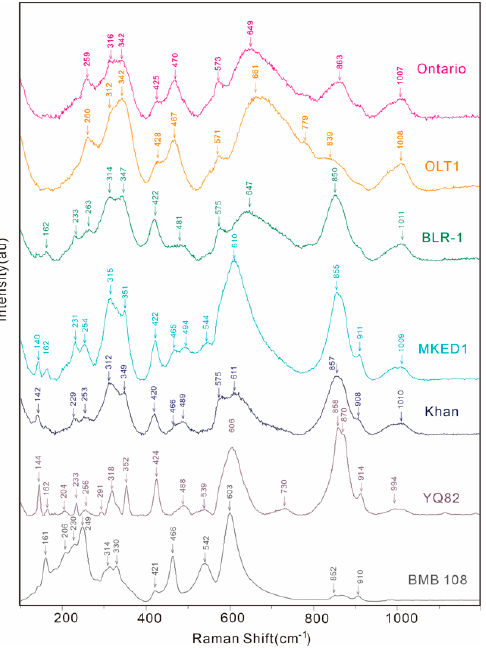
Figure 13. Raman spectra of common titanite reference samples (modified from a part of Figure 3 of Ling X-X et al., 2022) [46].